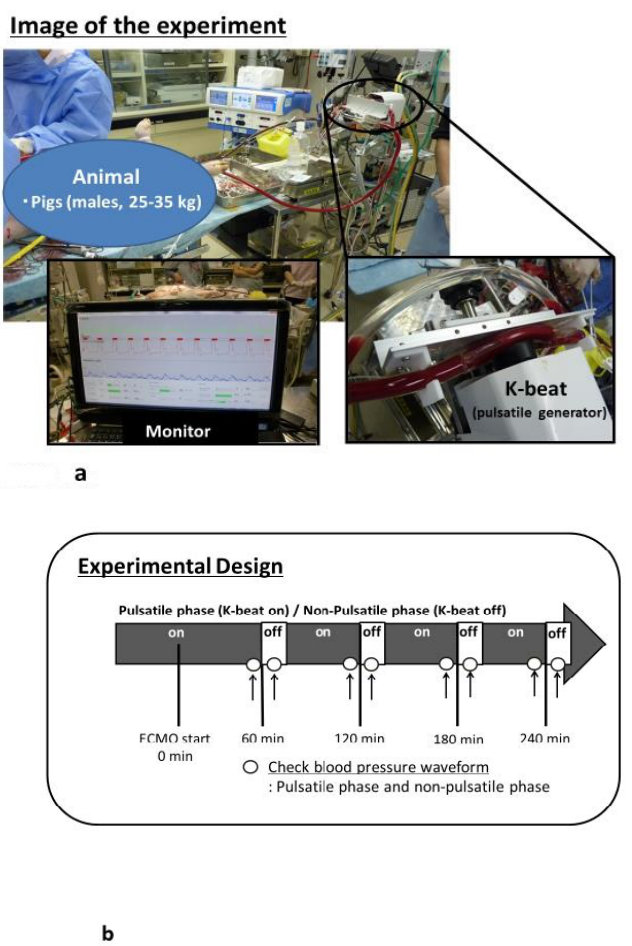
Figure 1. ( a ) Photograph of the experimental set-up. ( b ) Experimental design for pulsatile flow (K- beat on), and non-pulsatile flow (K-beat off).